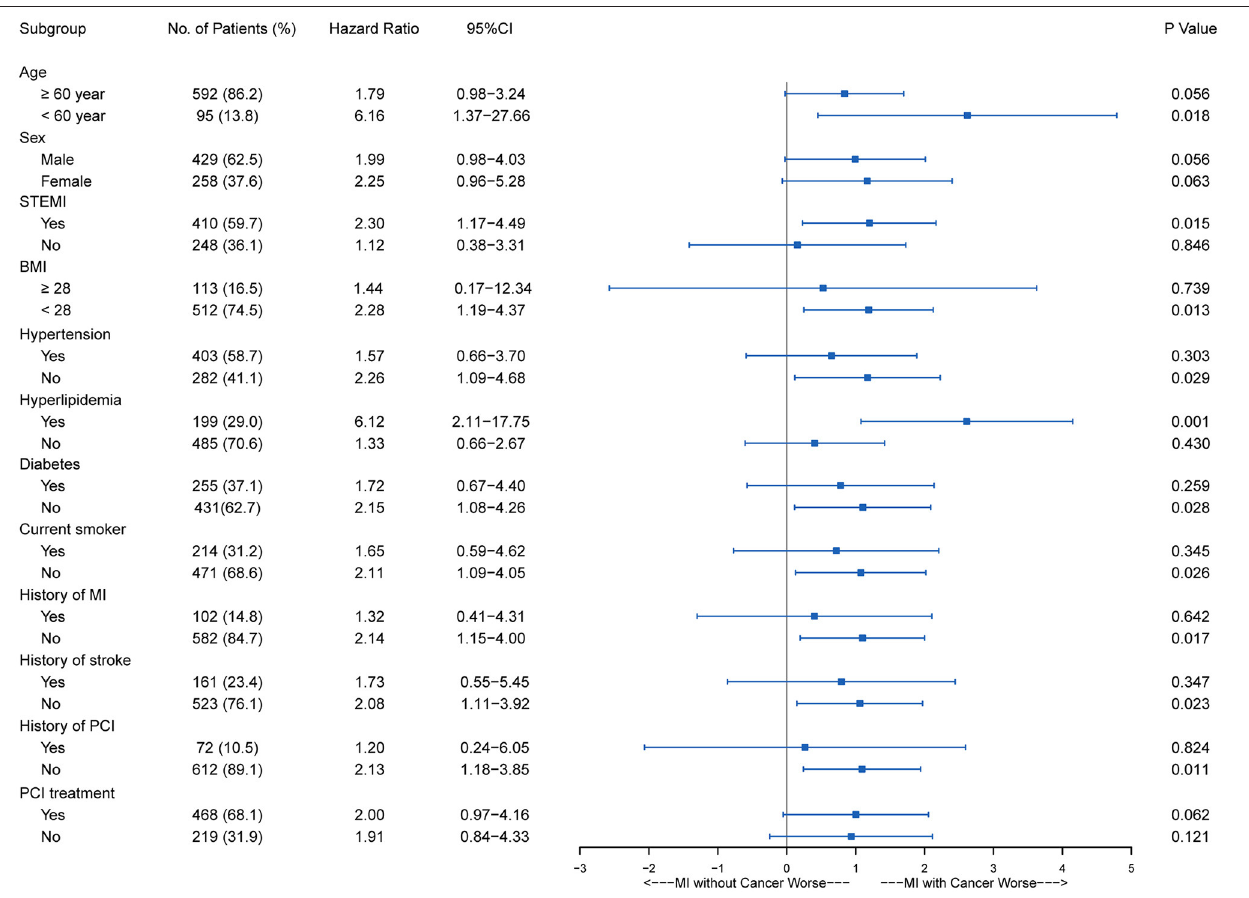
FIGURE 2 | Subgroup stratified analysis of cardiovascular survival among AMI patients with and without cancer. AMI, acute myocardial infarction; BMI, body mass index; CI, confidence interval; MI, myocardial infarction; PCI, percutaneous coronary intervention; STEMI, ST segment elevation myocardial infarction.